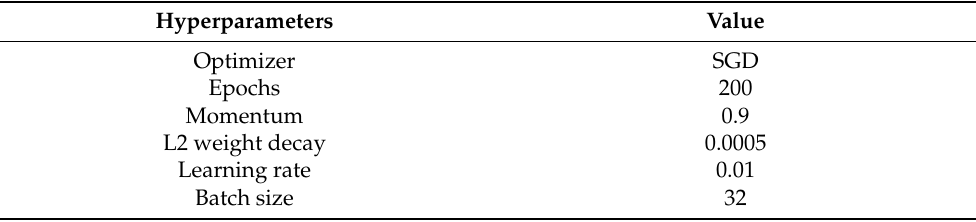
Table 4. Hyperparameters used in our